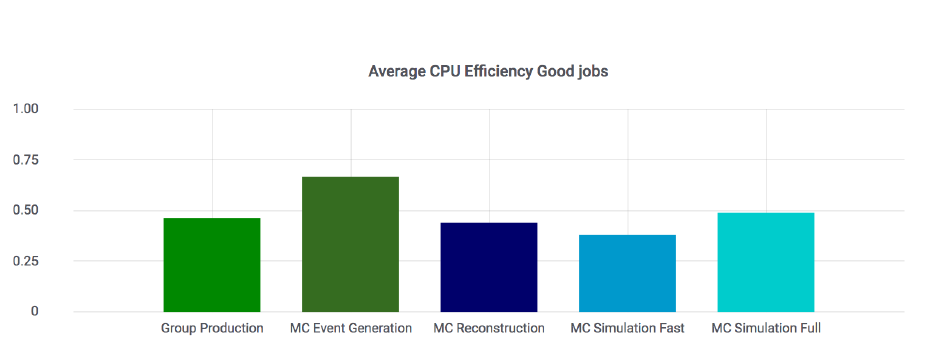
Figure 7: CPU e ffi ciency ( (cid:15) CPU ) for jobs in Oslo during the ARC true-pilot mode